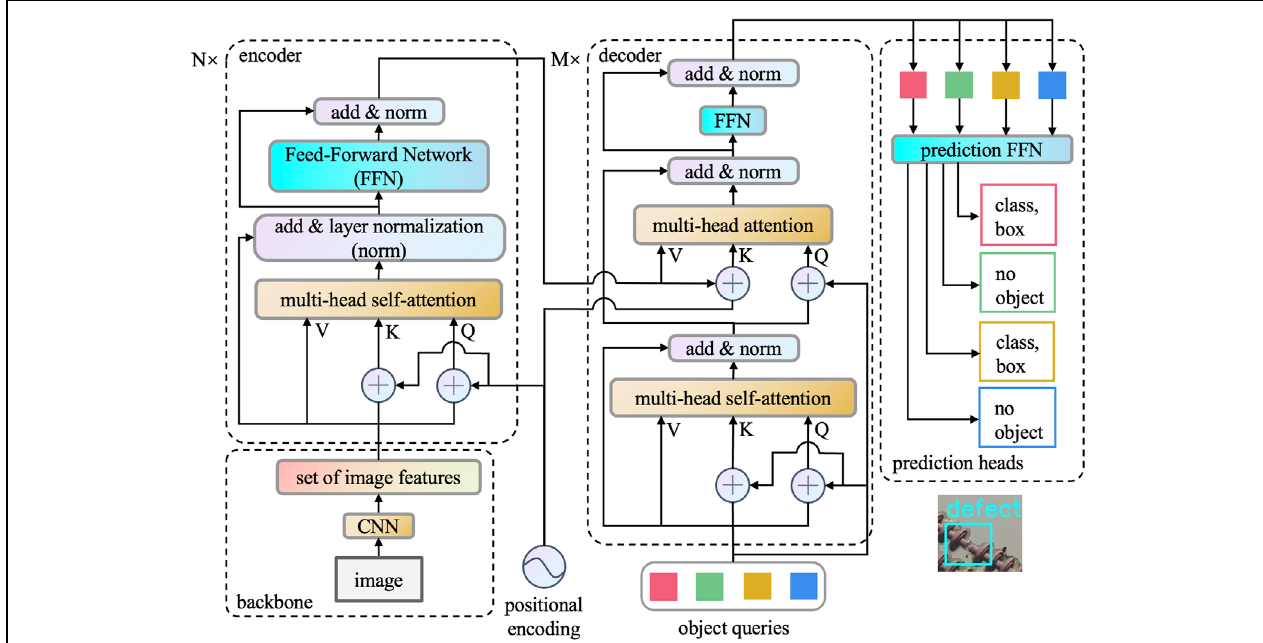
FIGURE 1 | DETR—model